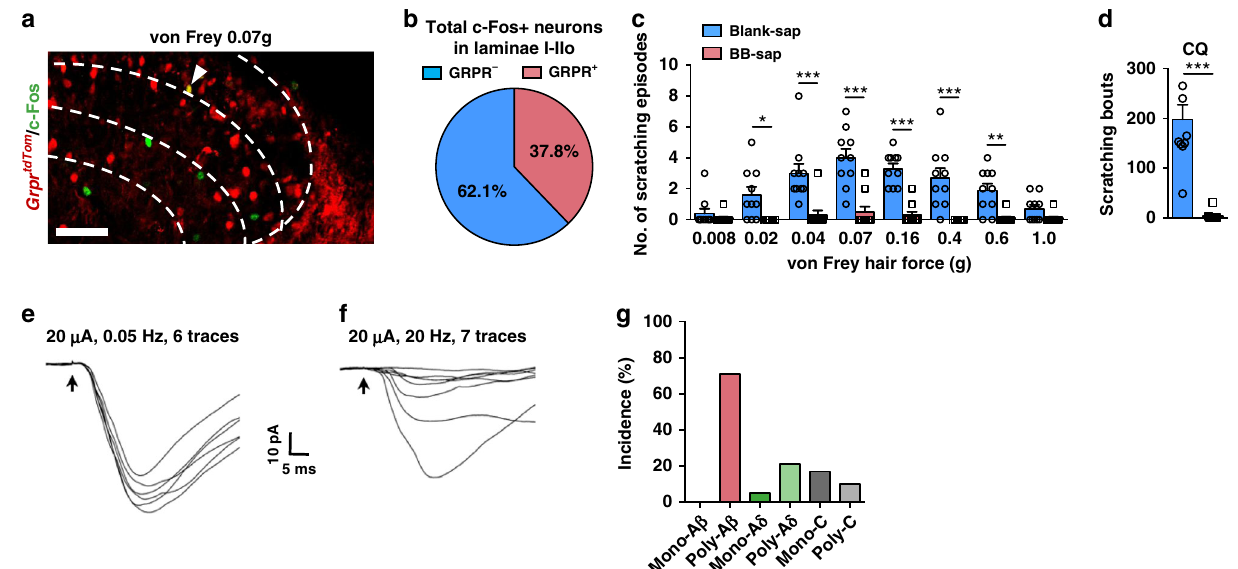
Fig. 5 Mechanical itch depends on GRPR neurons. a Representative image of c-Fos IHC (green) in the dorsal horn of Grpr tdTom (red) mice after von Frey hair stimulation (0.07 g) on the nape skin. Arrowhead indicates c-Fos + / Grpr tdTom + neuron. n = 3 mice. Scale bar, 50 μ m. b Quanti fi cation of the percentage of Grpr tdTom + /c-Fos + neurons in c-Fos + neurons in laminae I – IIo. n = 3 mice. c , d Mechanical itch test ( c ) and CQ itch test ( d ) after 500 ng of BB-sap treatment. ( c two-way ANOVA with Bonferroni post - hoc , * p = 0.018, ** p = 0.005, *** p = 0.00001, n = 10 mice per group; d unpaired two-tailed Student ’ s t- test, *** p = 0.00001, n = 10 mice per group). e , f Representative traces showing one Grpr tdTom neuron cannot follow 20 µ A/20 Hz stimulation. g Percentage of each types of inputs onto Grpr tdTom neurons. Data from fi ve mice, n = 42 neurons. All data are presented as means ± s.e.m. and error bars represent s.e.m. Source data are provided as a Source Data fi